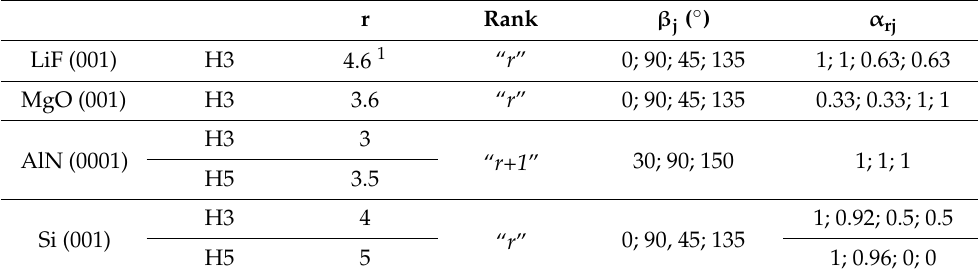
Figure 3. Illustration of the crystal surface structures and the directions of the considered polarizabilities for the calculations in Figure 2d. Table 1. Used parameters to calculate the polarization curves of Figure 2e using Equation (13).